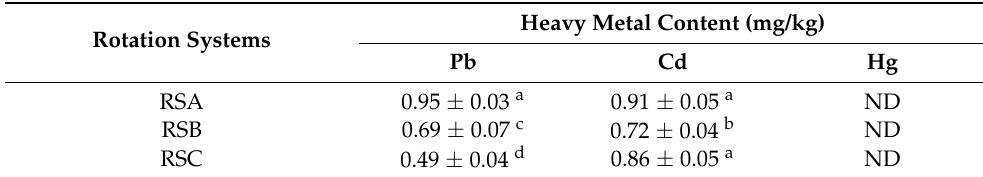
Table 6. Heavy metal content of M. importuna under different rotation systems. Different letters indicate a statistical difference ( p <